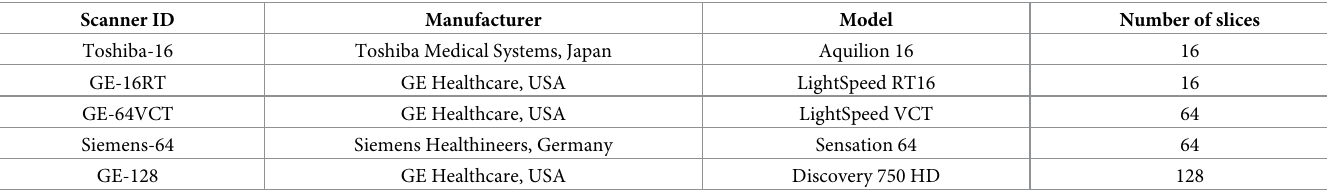
Table 1. CT scanners enrolled in the study. Scanner